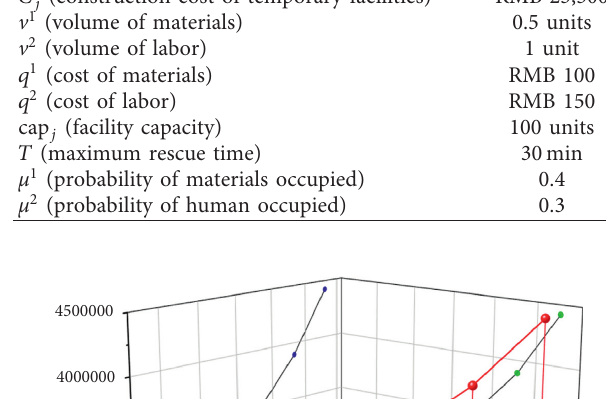
Table 6: Parameter assumptions. Parameters